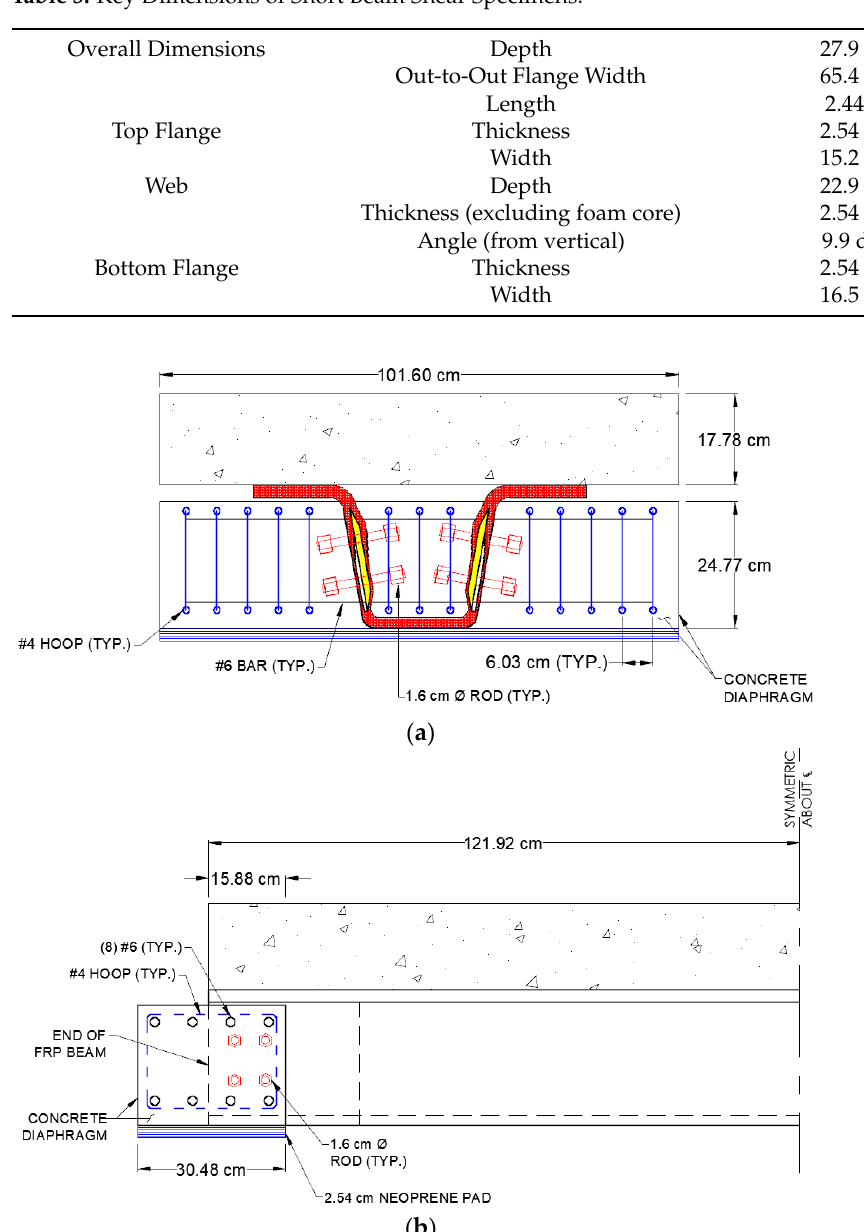
Table 3. Key Dimensions of Short Beam Shear Specimens.